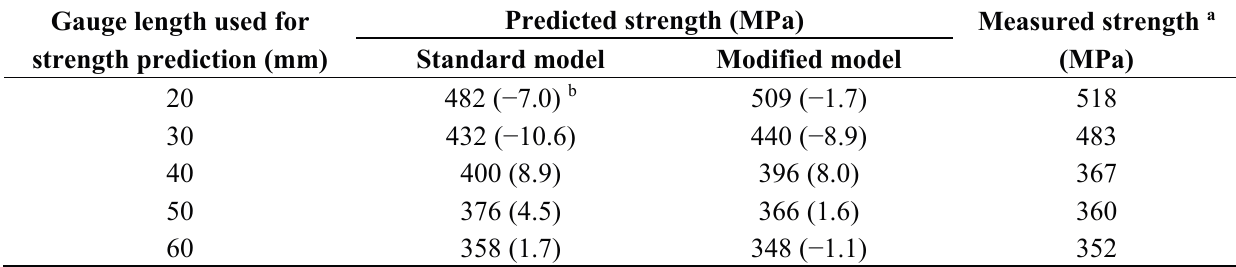
Table 4. Comparison of the measured and predicted tensile strength at different test